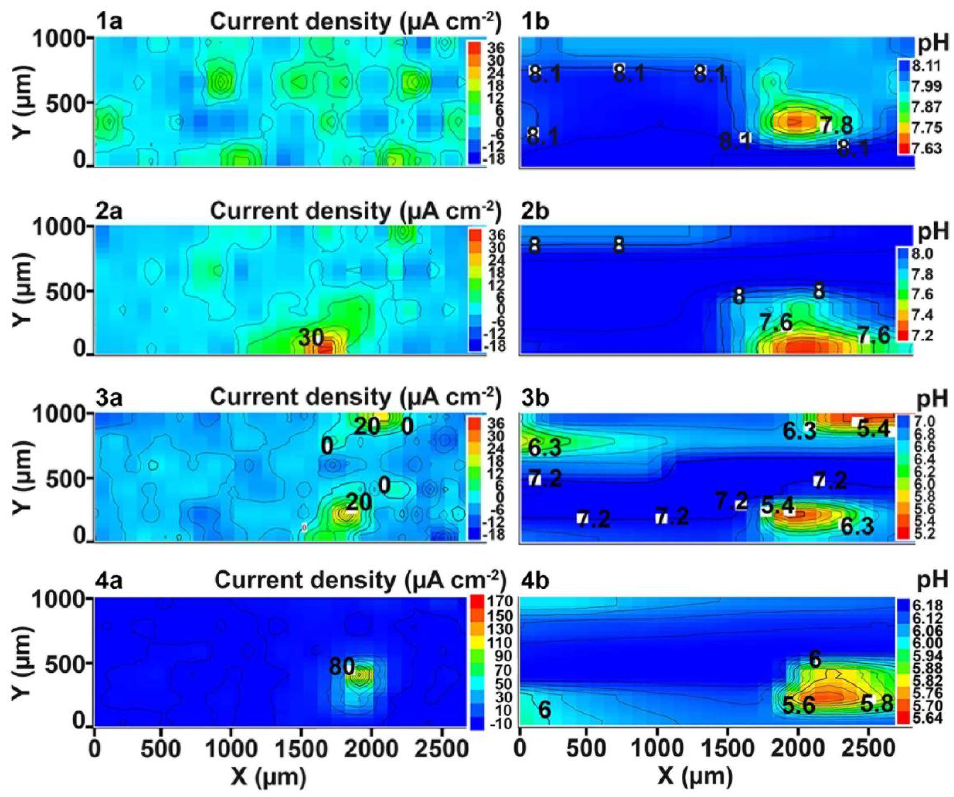
Figure 3. The ( a ) SVET and ( b ) SIET diagrams of the current density and pH distribution on the surface of the welded 1579 Al alloy sample after (1a,1b) 30, (2a,2b) 90, (3a,3b) 240, and (4a,4b) 510 min of exposure to 0.5 M NaCl. There is a migration of the anodic zone from the bottom part to the center (bulk of the material) of the investigated area during the exposure time.